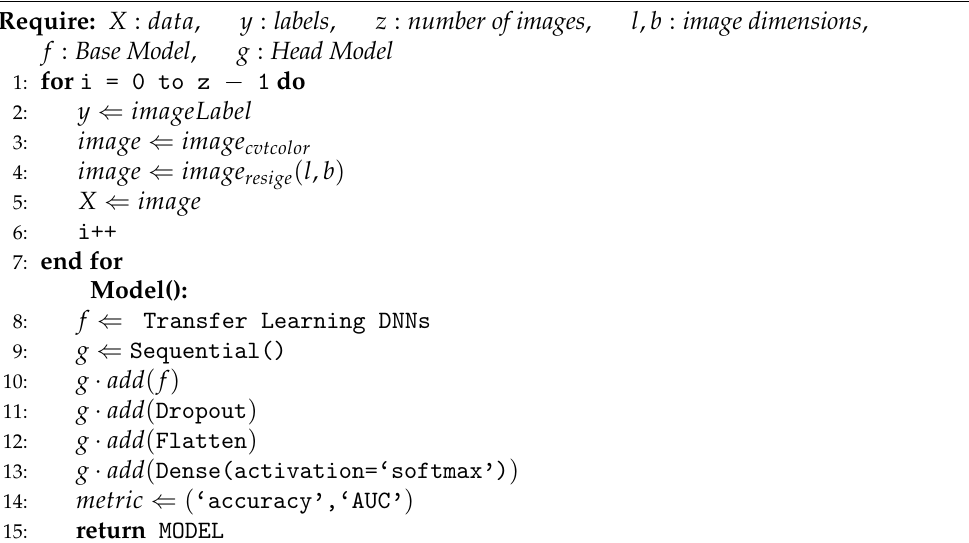
Algorithm 1 Model Input and Architecture of